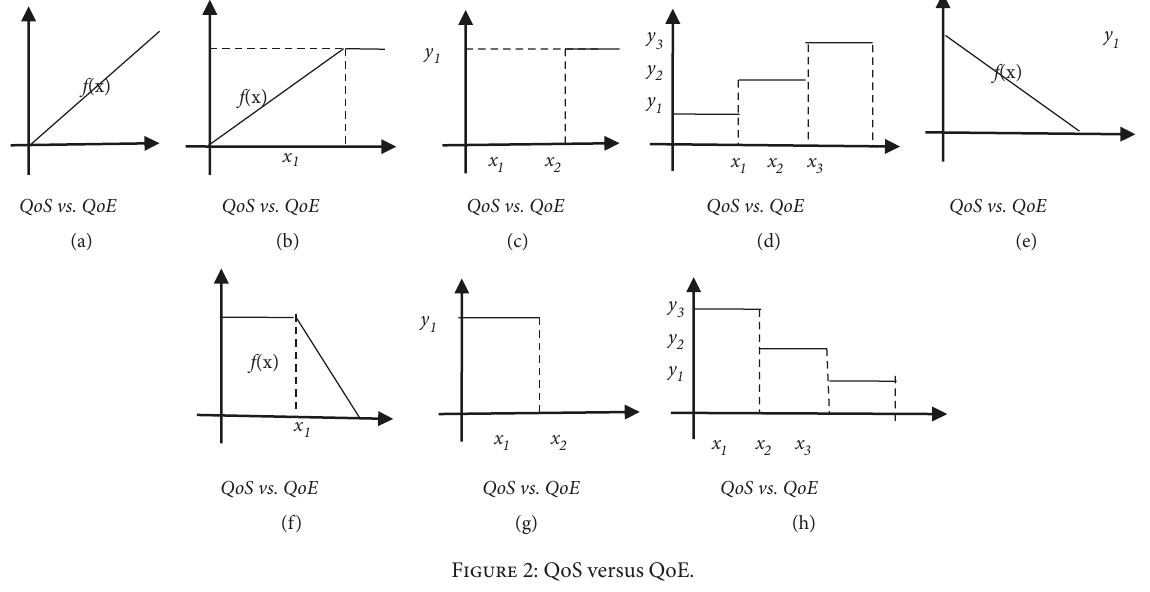
Figure 2: QoS versus